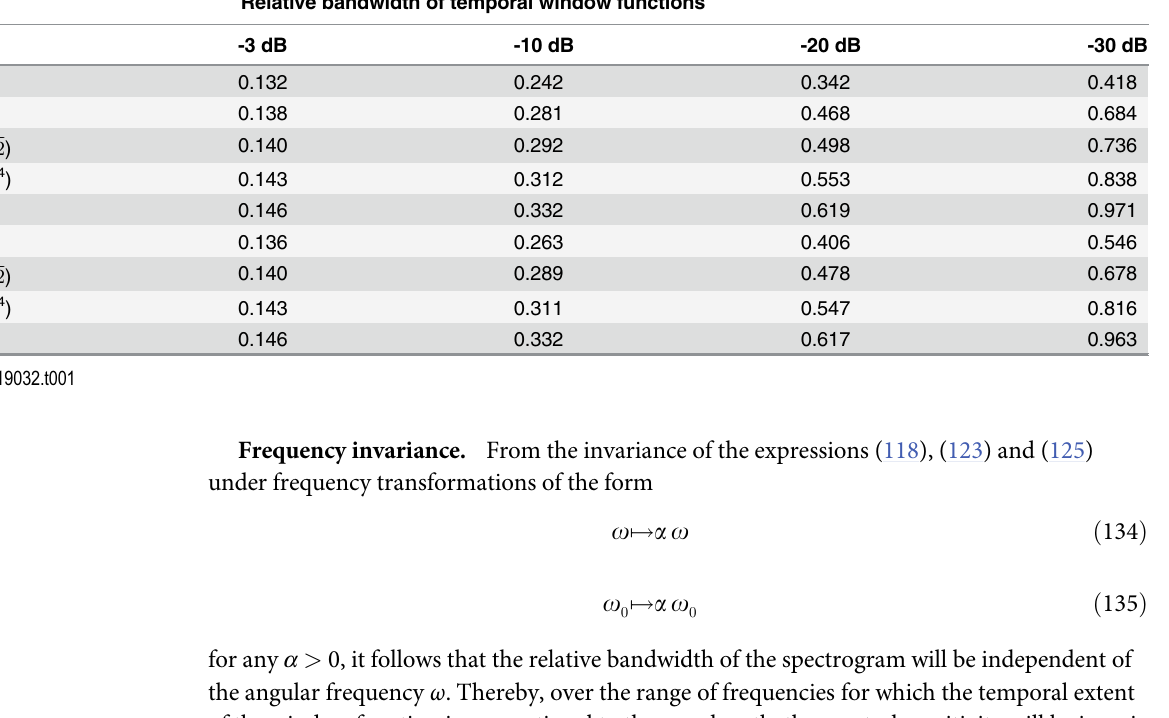
of the spectrogram according to (129), for a Gaussian function n